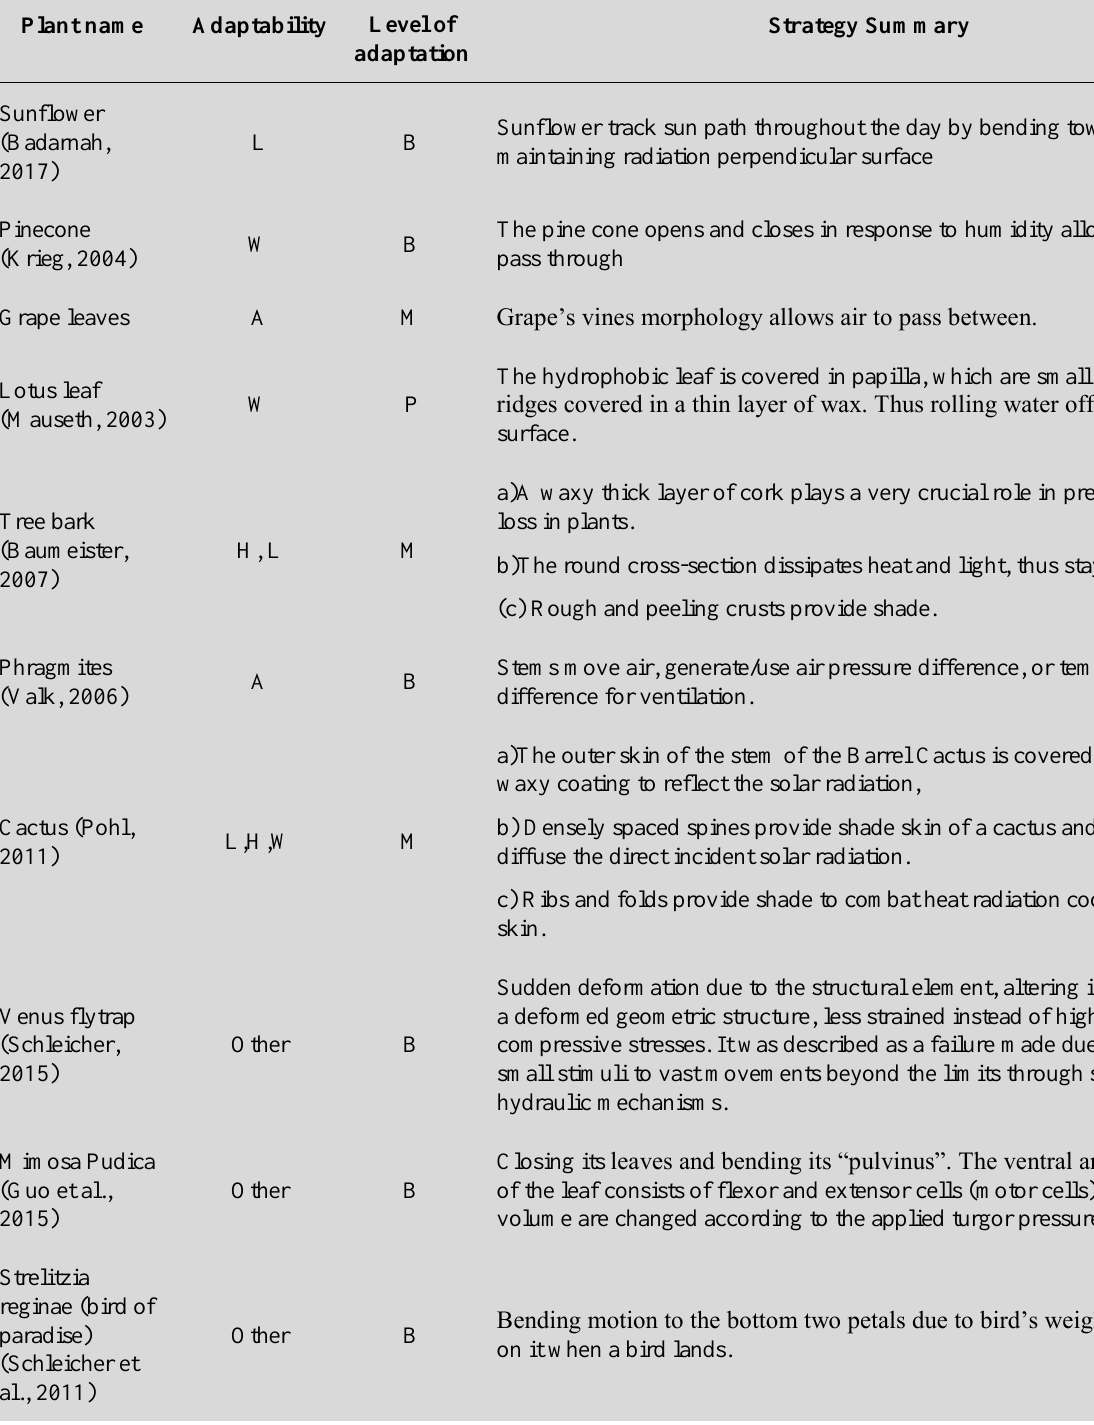
Table 1: Plants adaptive